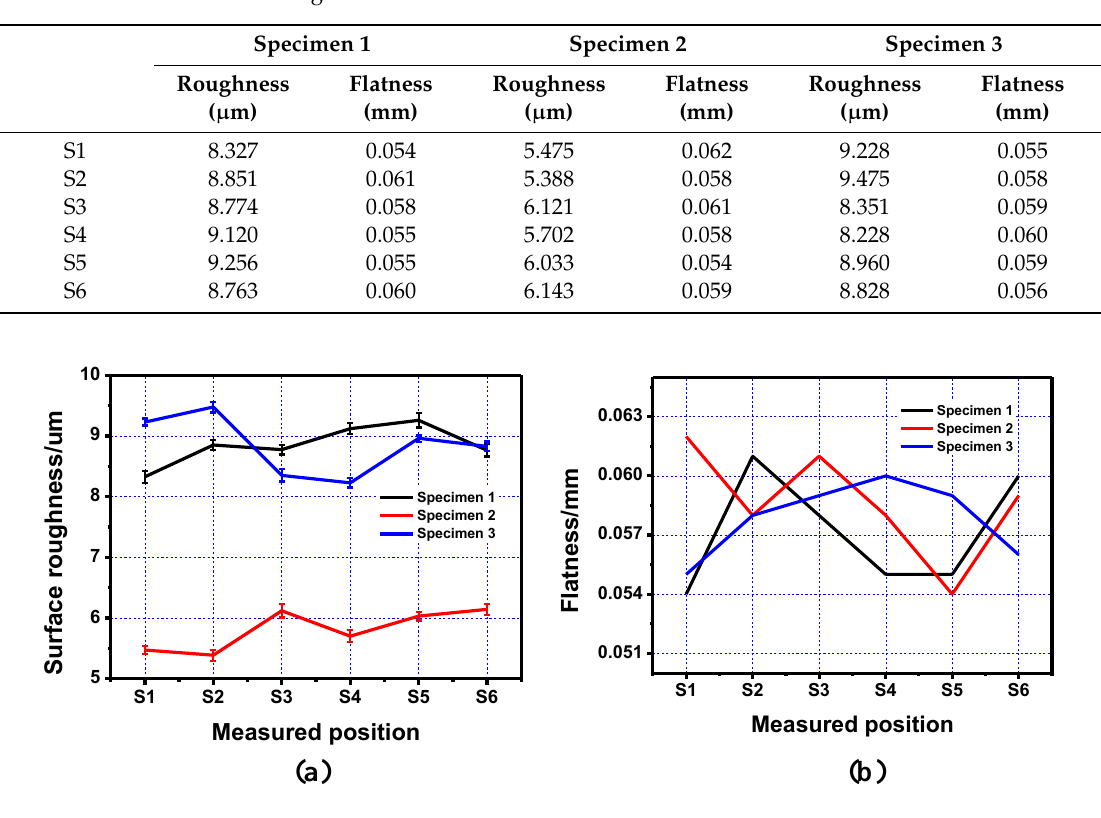
Figure 4. Line charts of roughness and flatness of the side surface on the inner structure printed using three di ff erent scan strategies. ( a ) Side surface roughness of the printed specimens; ( b ) Side surface flatness of the printed specimens.